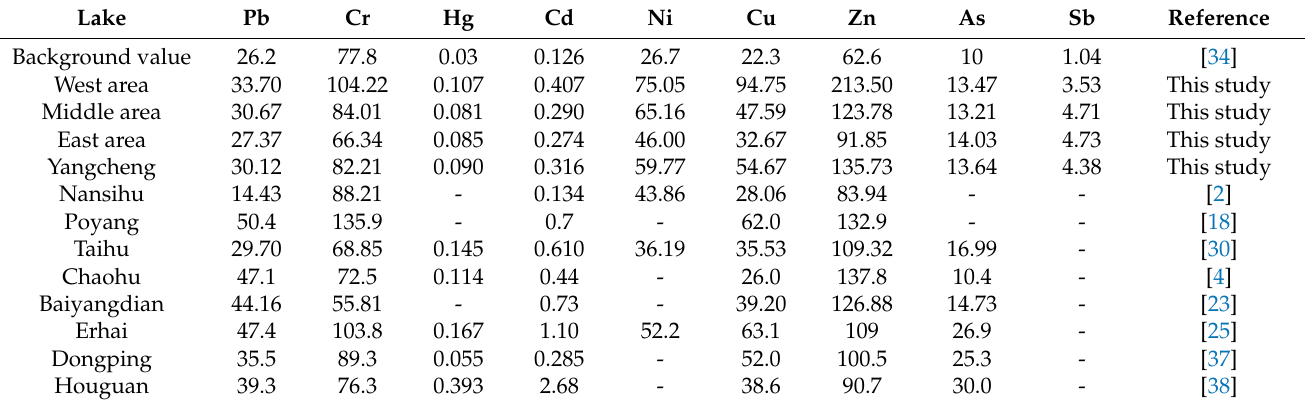
Table 2. The average concentrations of heavy metals in the surface sediment of Lake Yangcheng and comparisons with other freshwater lakes (unit: